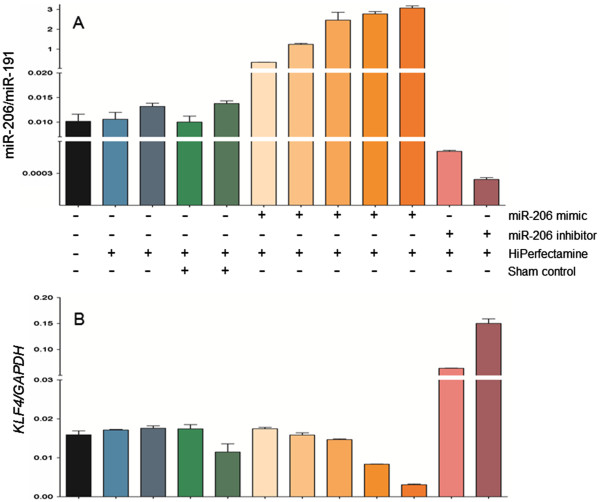
Knockdown and ectopic upregulation of miR-206 reciprocally regulates KLF4. Human HCT116 colon cancer cells were transfected with increasing concentrations of a miR-206 mimic (graded orange-shaded bars indicating increasing miR-206), or miR-206 inhibitor (pink bars). Black, blue, and green bars designate the various controls, as mentioned in the text. (A) miR-206/miR-191 expression and (B) KLF4/GAPDH levels were measured as described for human primary colon cancers, see Figure
3 legend. Data bars = mean ± SD, n = 3.